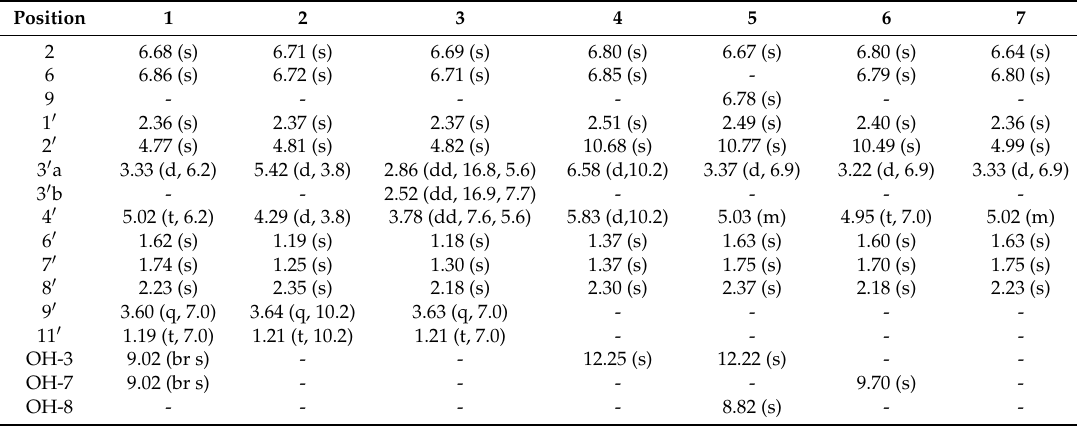
Table 2. 1 H-NMR Data ( δ , ppm) of compounds 1 – 7 ( 1 – 5 , 7 in acetone- d 6 , 6 in DMSO- d 6